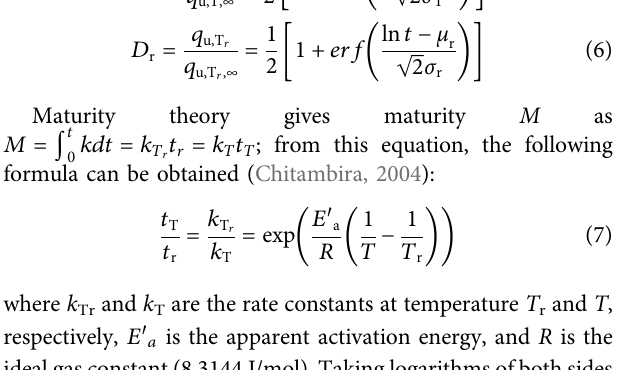
FIGURE 11 | Comparison of measured and predicted